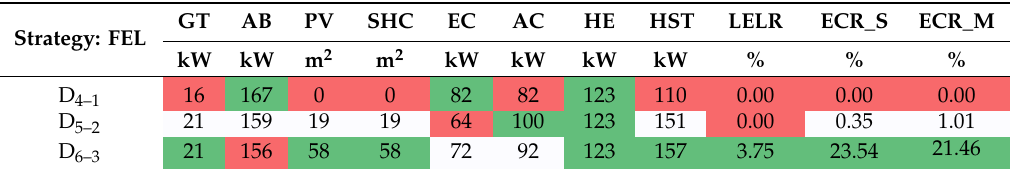
Table 7. The absolute deviation of optimal design between uncertain cases 4–6 and their deterministic cases